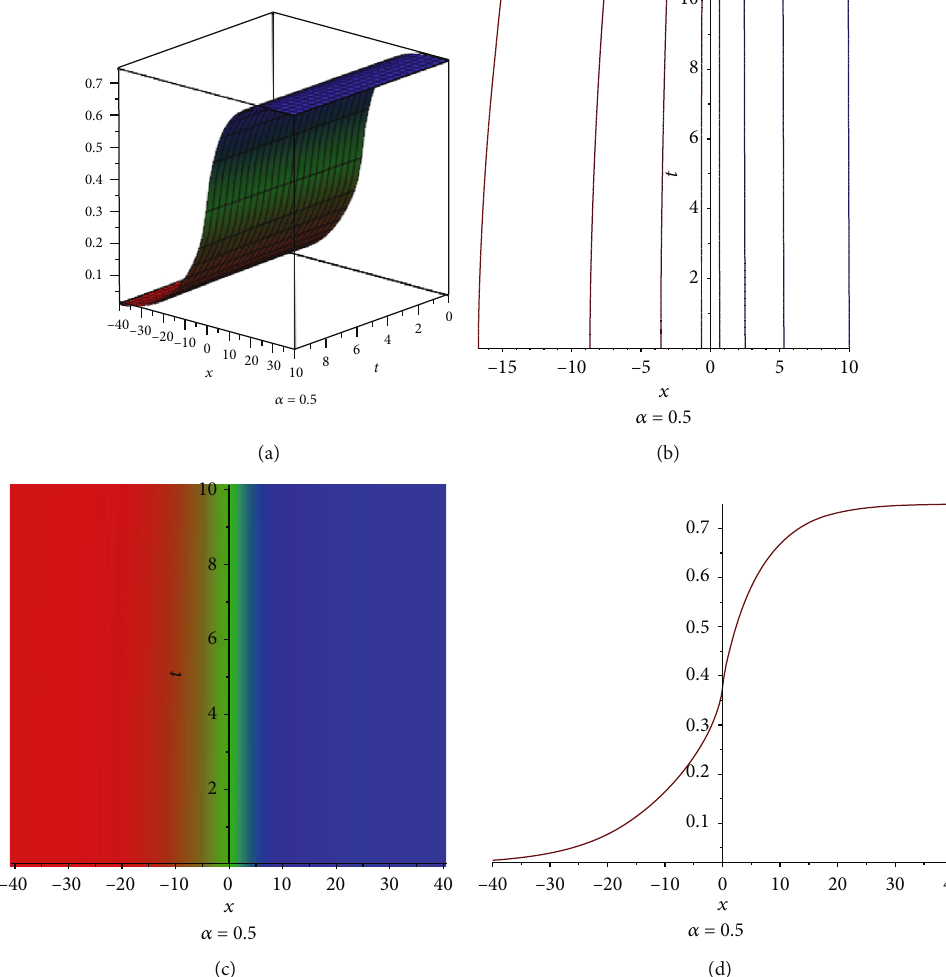
= 0 : 3, δ = δ = d = d = 0 : 1, 1 2 3 1 2